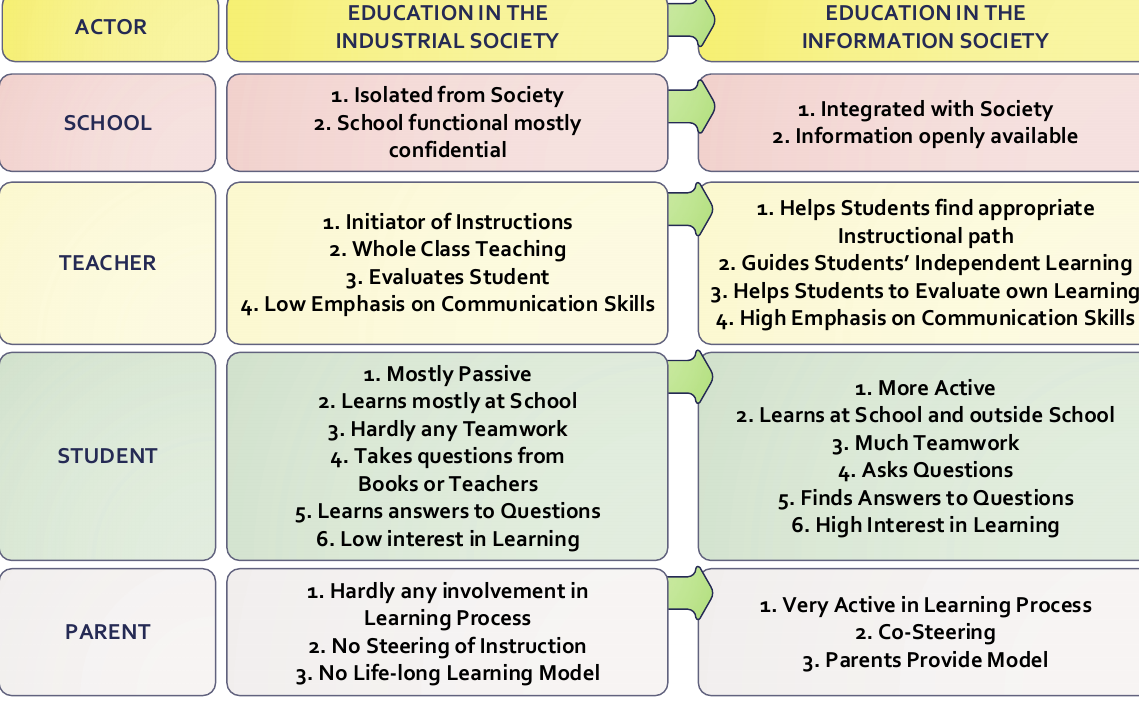
Figure 2 : Roles Transformation from Industrial Society to Information Society